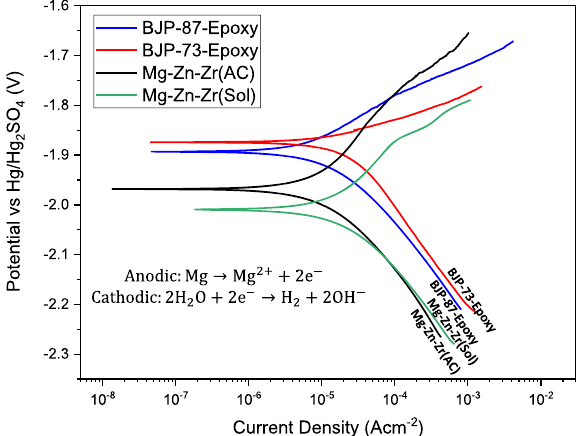
Fig. 5 Potentiodynamic polarization of casted and BJP-epoxy Mg- Zn-Zr alloys. Potentiodynamic polarization curves of as cast and the epoxy sealed BJP-87 and BJP-73 magnesium alloy after 30 min immersion at OCP in 0.1 M sodium sulfate solution at room temperature. Current densities for the BJP samples have been corrected for the area fraction of Mg alloy (as opposed to epoxy) exposed to the electrolyte.